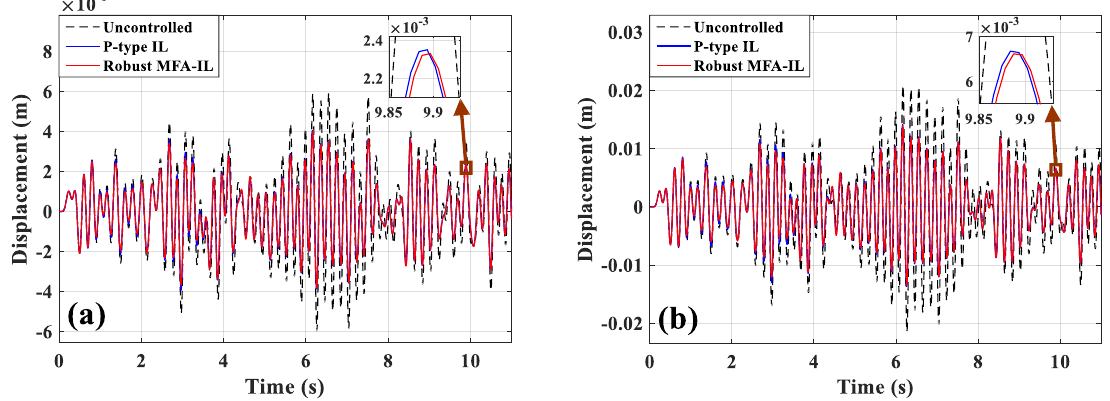
Figure 10. Displacement responses: ( a ) Point A, ( b ) point B.